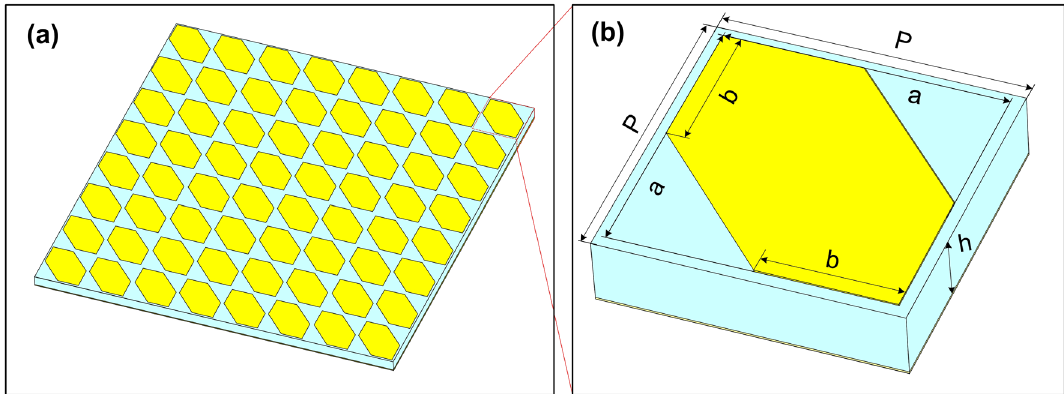
Figure 1. Schematic of the proposed polarization: ( a ) tilted top-view and ( b ) 3D-view of a unit